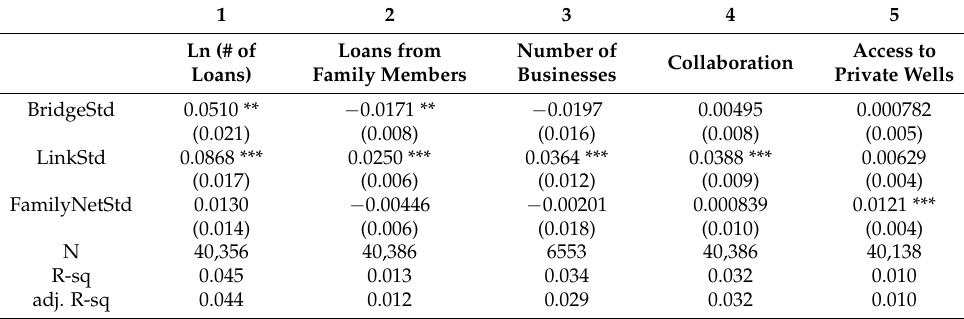
Table 4. Exploring the motives for investment in social